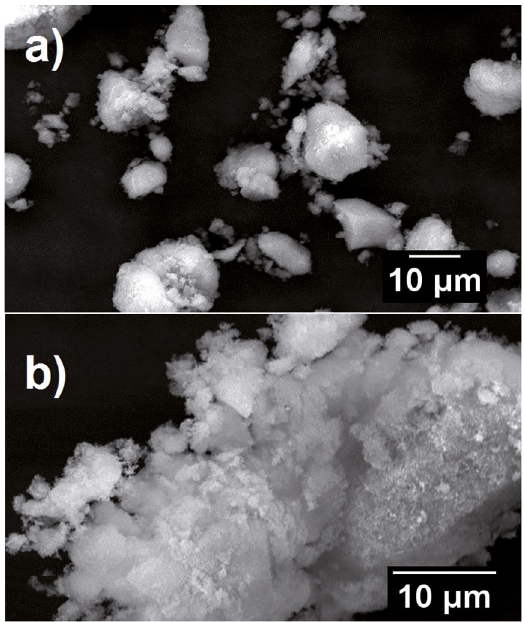
Figure 4: Image (a) show precipitated powders and (b) calcined powders. Particle size was estimated by laser granulometry to vary from 0.1 to 100 µm (Figure 5) and the calcined powder specific surface area is 11.70 m²/g. Bioactive materials